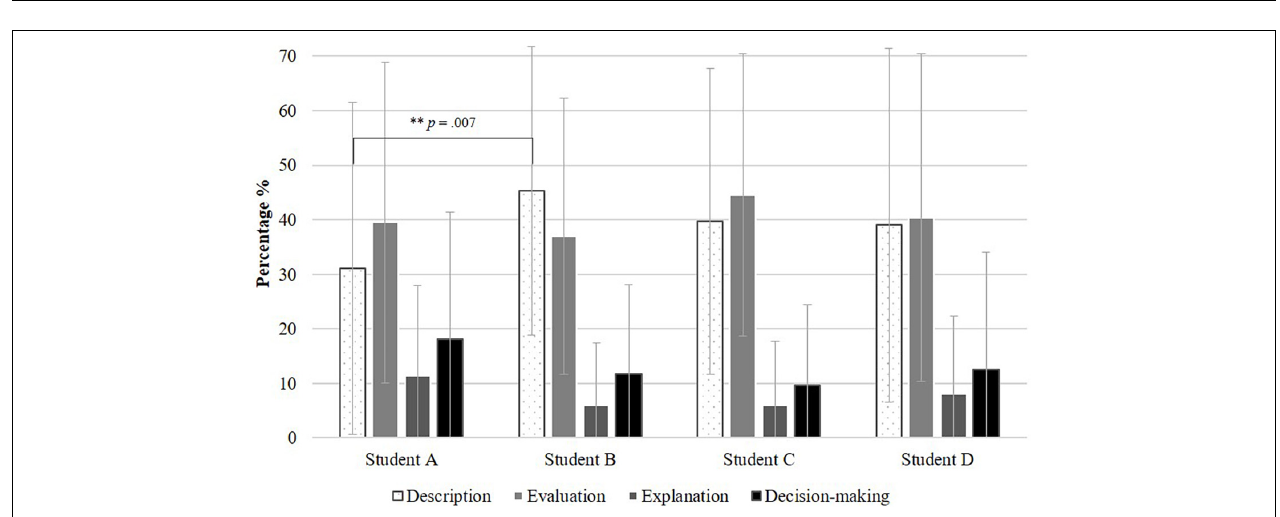
FIGURE 6 | Distribution of knowledge-based reasoning activities with the following significance level: *** p < 0.001.